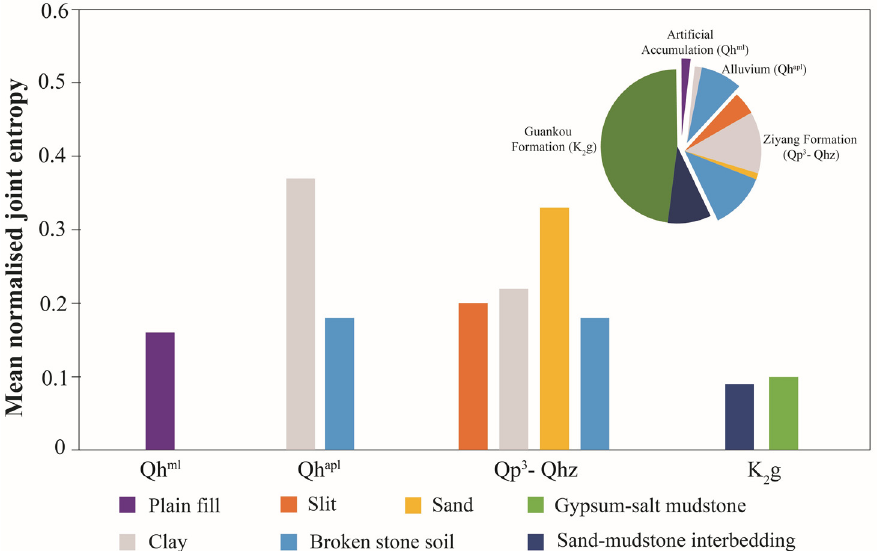
Figure 8. Average value of normalized joint entropy and statistics of cell number of each lithologic class. The bar chart displays the average value of normalized joint entropy. The pie chart on the upper right represents the percentage of cell numbers of each lithologic class in the reconstruction space. Rocks or soils in the same stratum were gathered together, and the different lithologic classes were distinguished by colors.